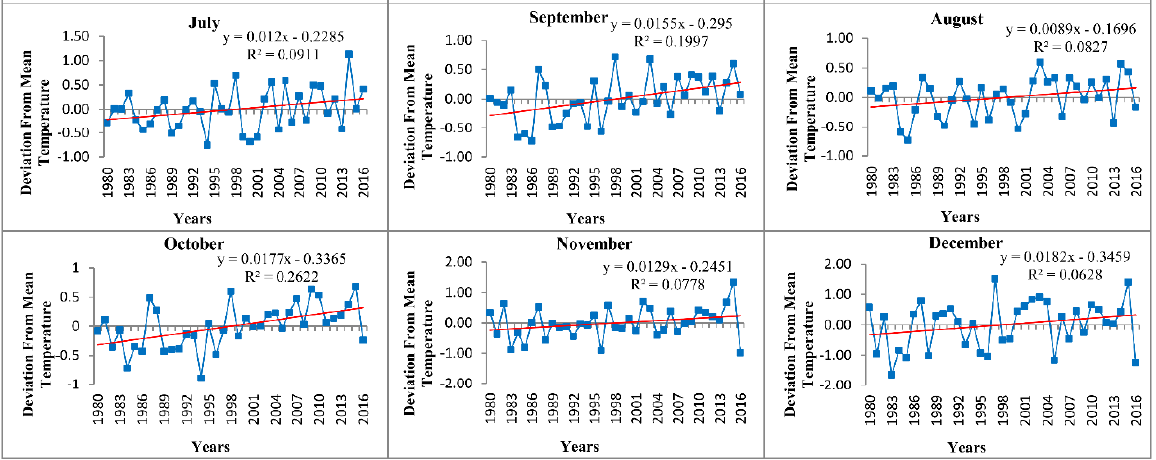
Figure 11. Monthly Temperature trends over Konkan and Goa